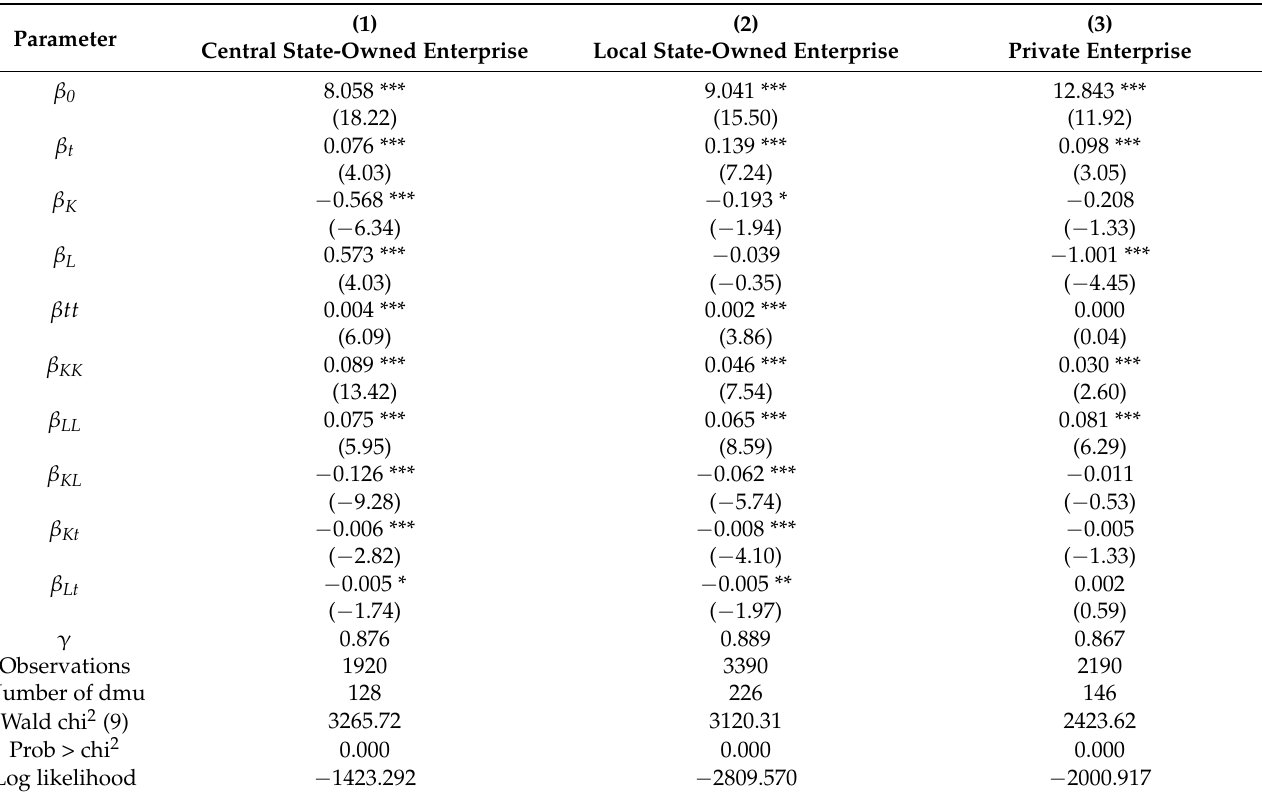
Table 3. SFA estimation results of all ownership